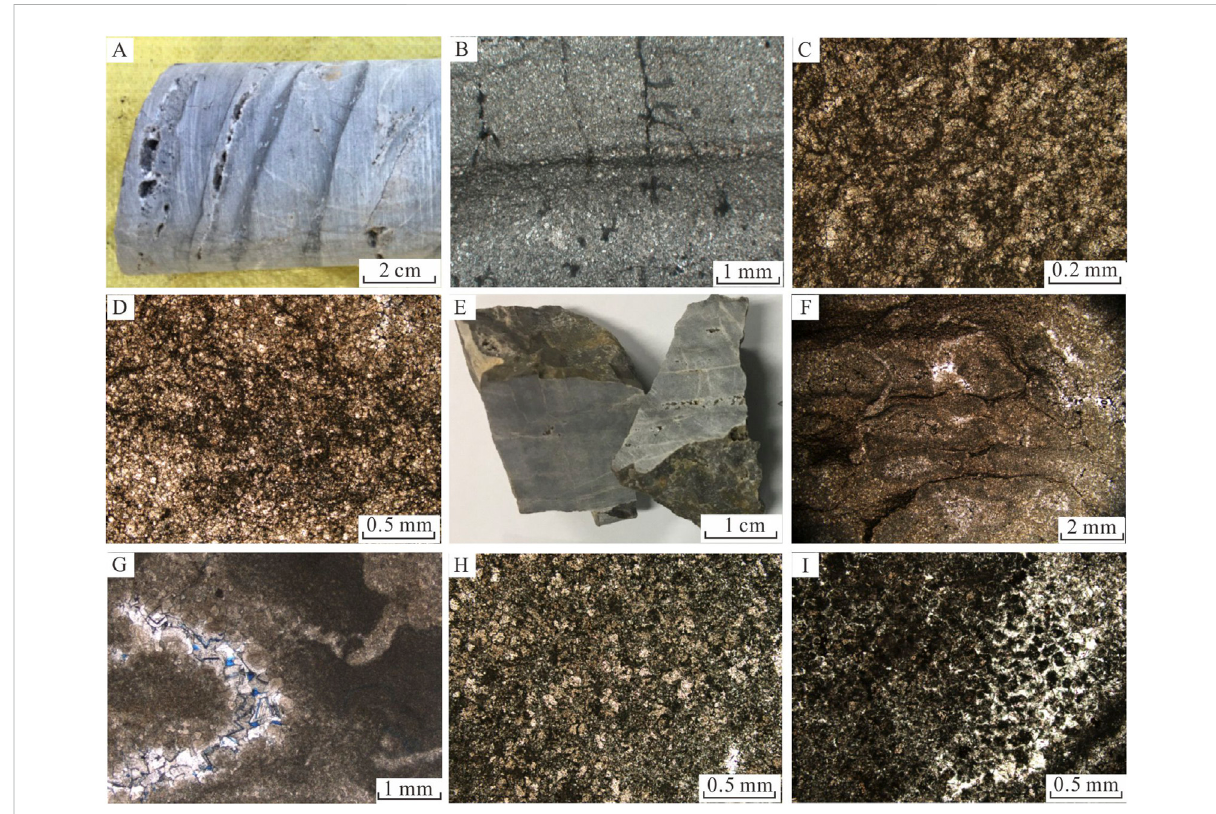
FIGURE 3 MaintypesoflithofaciesoftheXiaoerbulakeFormationinwellXKD-1 (A). Laminateddolostone,112 m; (B) .Theclearlaminatedstructure,mainly composed of micritic-silty dolomite, 95.2 m, sample XKD1-44; (C) . Bacteria-bonded dolostone, mainly composed of micritic-silty dolomite, with a dark network bacteria-bonded structure, 58.8 m, sample XKD1-13; (D) . Bacteria-bonded dolostone, mainly composed of micritic-silty dolomite, with a dark lumpy bacteria-bonded structure, 70.1 m, sample XKD1-21; (E) . Thrombolite dolostone, with dark clots unevenly distributed, 96.6 m; (F) . Thrombolite dolostone, internally composed of dark micrites and with the unclear boundary, 57.2 m, sample XKD1-11; (G) . Thrombolite dolostone, with dark irregular bacterial lumps, cement dolomite fi lling among these lumps, and a few residual pores, sample XKD1-22; (H) . Grain dolostone with an unclear bacteria-bonded structure, 44.4 m, sample XKD1-4; (I) . Grain dolostone with an unclear bacteria-bonded structure, 45.3 m, sample